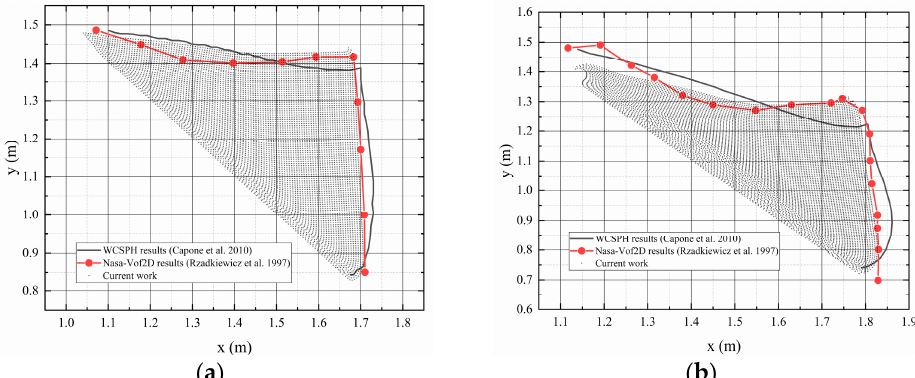
Figure 18. Phase B comparison between results from the current work, WCSPH [65], and Nasa-Vof2D [58]. ( a ) t = 0.4 s; ( b ) t = 0.8 s.